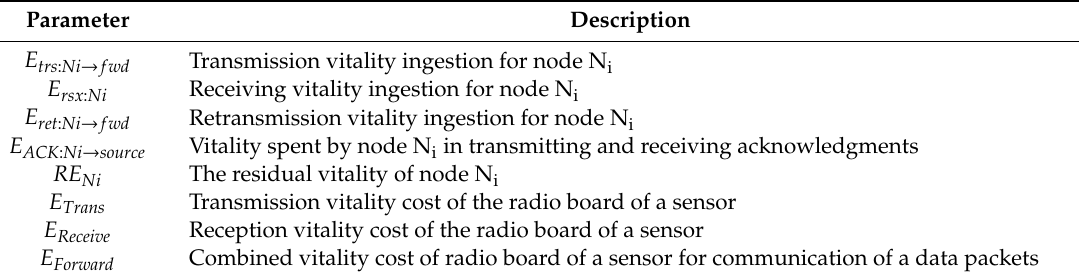
Table 2. Description of various terms used in the